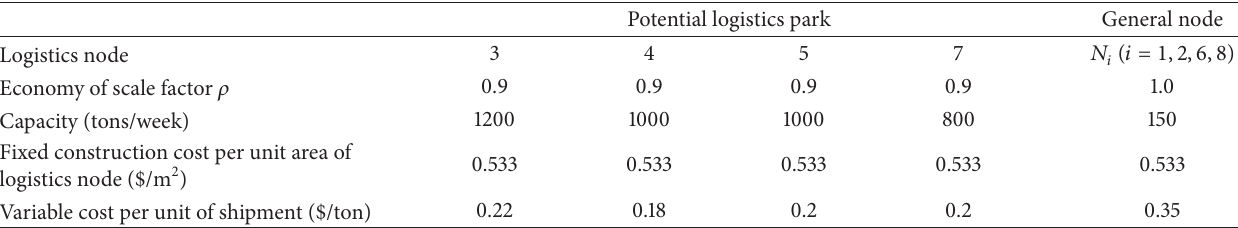
Table 4: The operator parameters on logistics node.